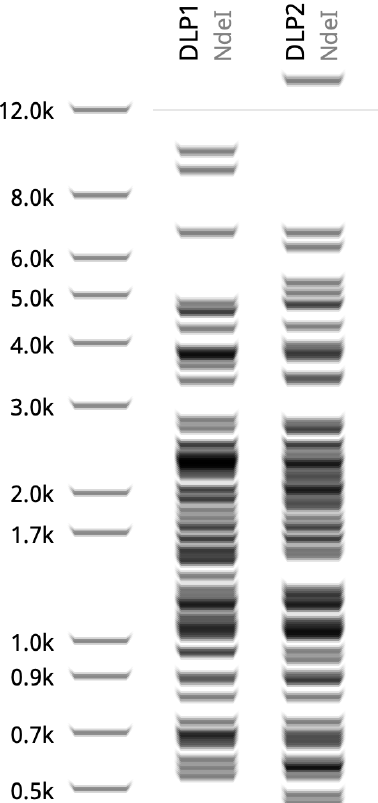
was digested for 5 h at 37 °C with Nde I and separated on a 1.2% agarose gel in 1x TAE (pH 8.0). L: 1 kb Plus GeneRuler DNA Ladder (Thermo Scientific); UC: uncut control.